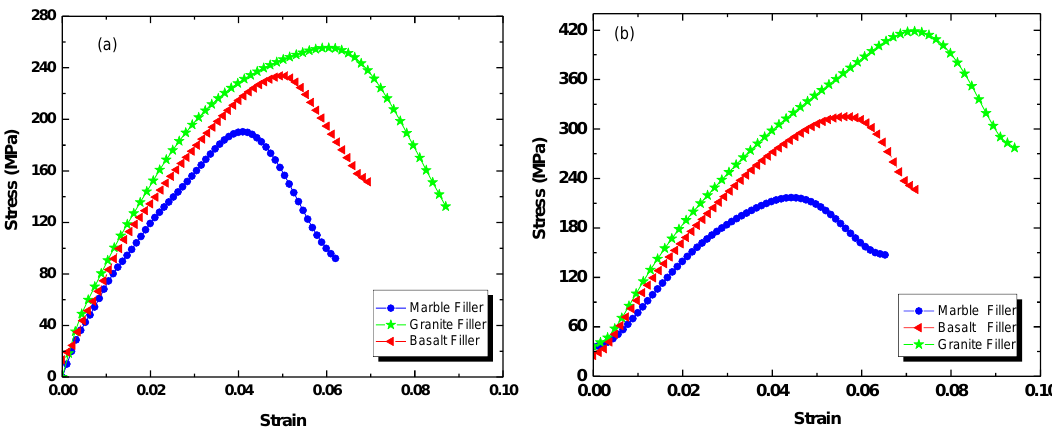
Figure 5. Flexural stress-strain curves of acrylic solid surface nanocomposites. ( a ) PMMA/SiO 2 /SSF and ( b ) PMMA/clay HNTs/SSF.